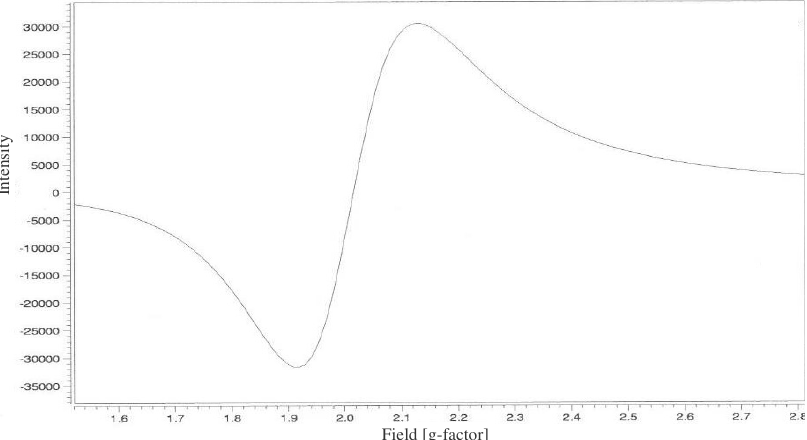
Figure 4. Electron paramagnetic resonance spectrum of Mn(II)-L 1 L 2 mixed ligand complex Seed germination